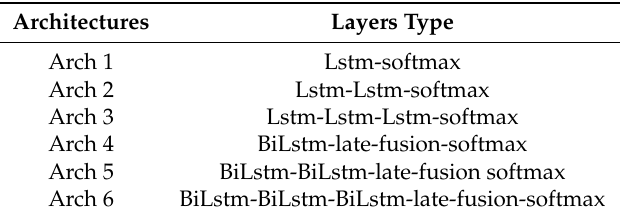
Table 1. LSTM and proposed bidirectional LSTM architectures (BiLstm).